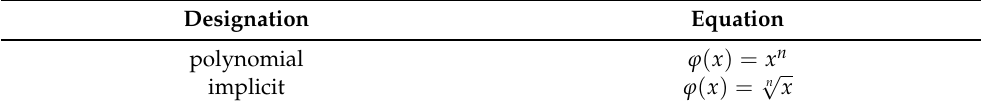
Table 4. Basic automorphism